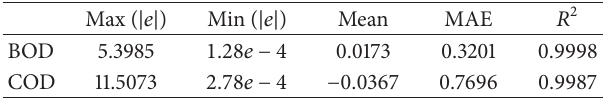
Table 1: Error functions for the developed model predicting BOD and COD